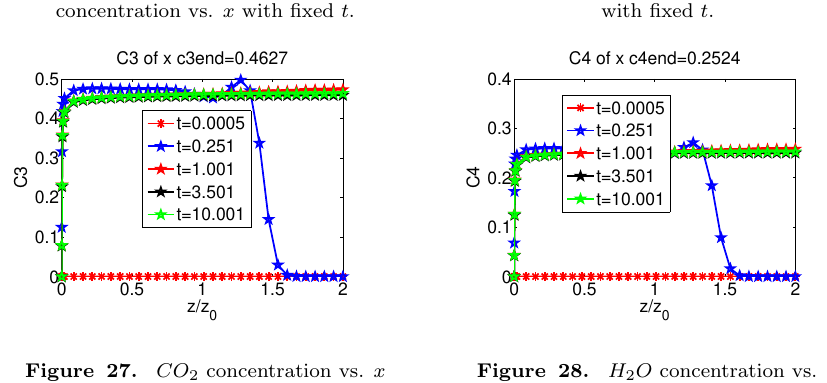
Figure 26. O 2 concentration vs. x with fixed t .